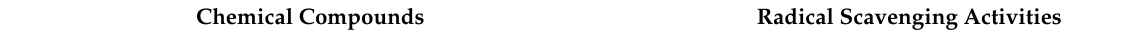
Table 1. Total phenolic and flavonoid content and antioxidant activities of ethanol extract from garlic juice processing waste